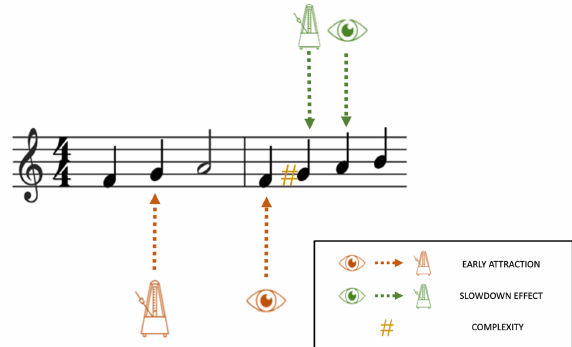
Figure 6. Within-staff variation of ETS as a function of the location of the